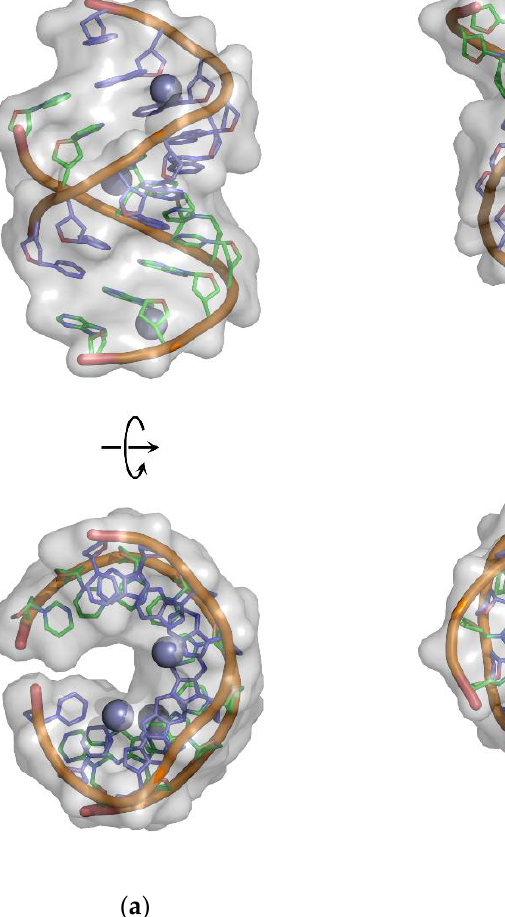
contoured at 1.0 σ and the refined structure of the overhanging duplex with Zn 2+ . The DNA and 2′ -